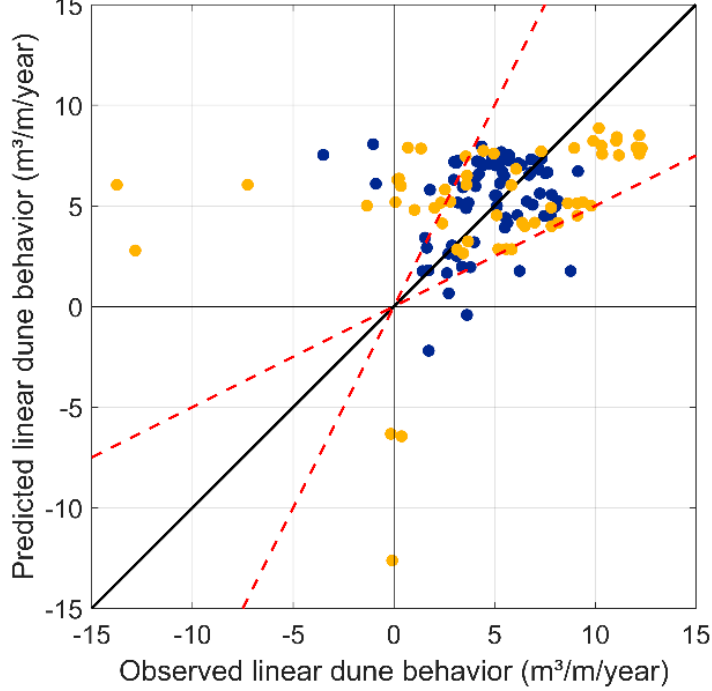
Figure 26. Comparison between observed and predicted linear dune development. Diagonal lines represent the one-to-one correspondence. Red dashed lines show the factor of two variance. Yellow dots represent the locations where managing activities are carried out.